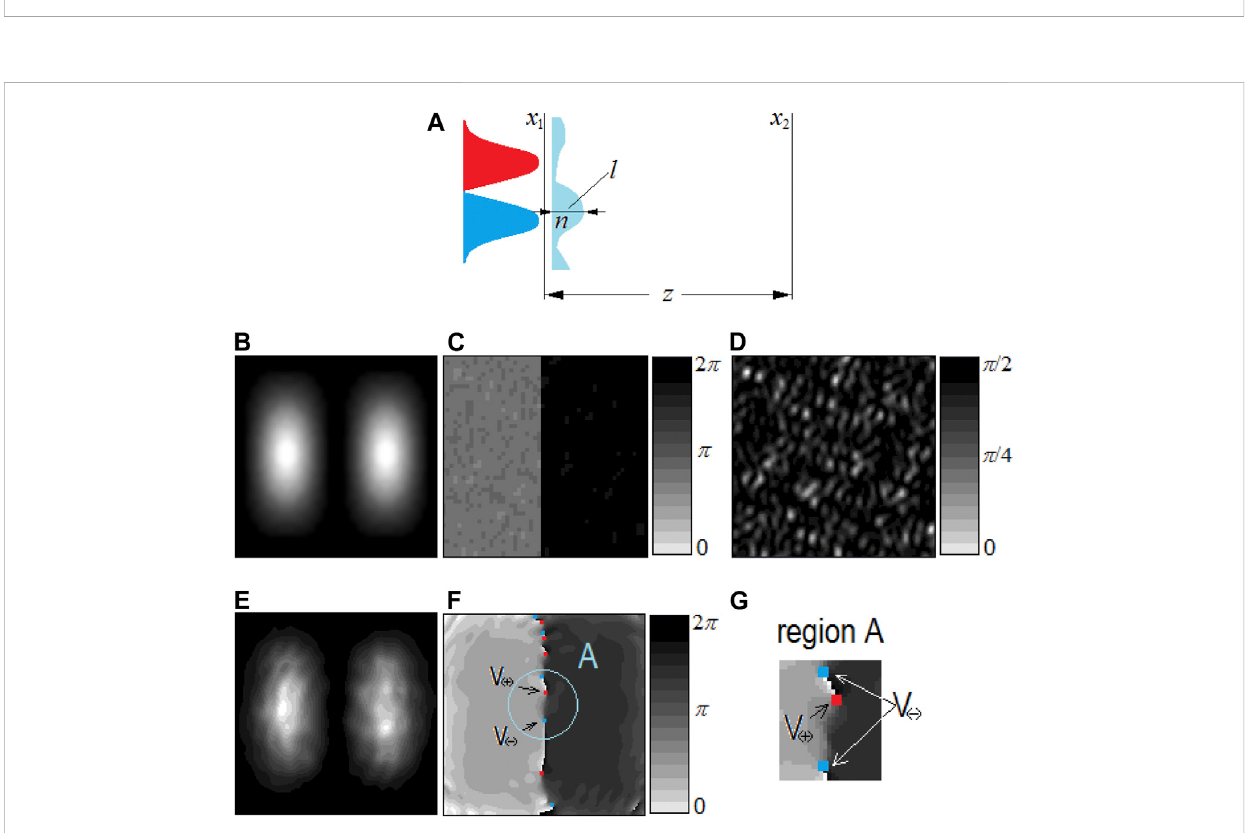
FIGURE 11 Transformation of the ED after passing through a thin random phase plate. (A) The model illustration; (B) intensity distribution immediately behind the phase plate; (C) phase distribution immediately behind the phase plate; (D) the phase modulation implemented by the phase plate; (E) intensity distributionin thefar fi eld behind thephase plate; (F) phase distributionin the far fi eld behind the phase plate; (G) magni fi edregion of the fi eld marked by the light ring in (F) . Red (blue) square denotes the vortex of positive (negative)